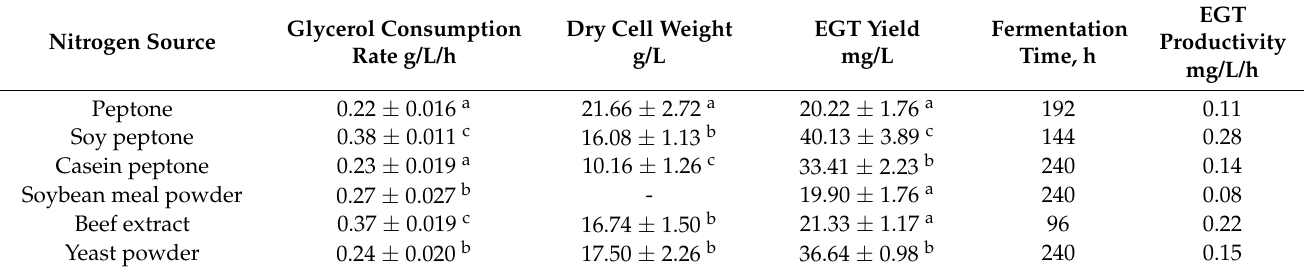
Table 1. Effect of different kinds of nitrogen sources on EGT production.